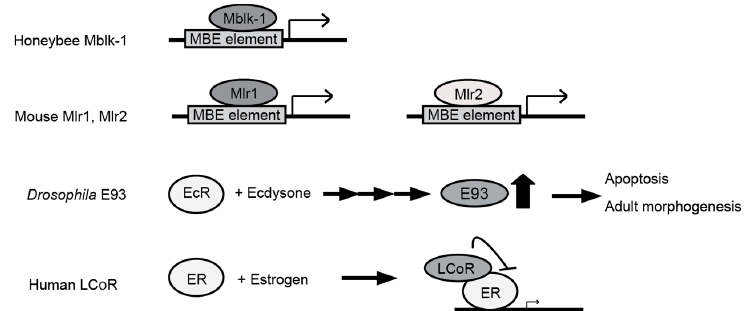
Figure 2. Reported functions and regulations of Mbk-1 family proteins. Honeybee Mblk-1 binds to MBE sequence in vitro, and activates transcription of the downstream gene. Mouse Mlr1 and Mlr2 also show MBE-dependent transactivation activity. Expression of Drosophila E93 is upregulated by ecdysteroid in pupal stages, likely under the control of ecdysone receptor (EcR) complex. E93 is required for expression of genes related to apoptosis and adult body patterning. Human LCoR interacts with estrogen receptor (ER) and suppresses transcription of ER target genes, but recent studies suggest that it may also act to enhance transcription of several target genes.